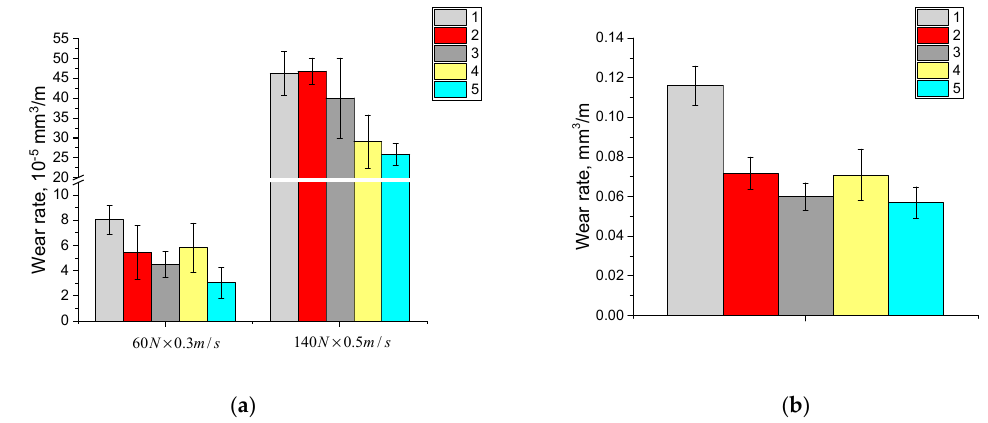
Figure 6. Diagrams on wear rates at dry sliding friction ( a ) and abrasive wear ( b ): 1—neat GUR 2122; 2—neat GUR 4120; 3—neat GUR 4022-6.